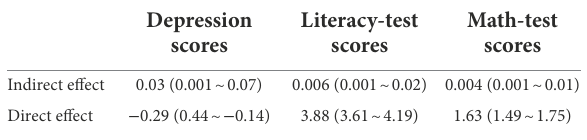
TABLE 7 Mediating effect of life satisfaction. TABLE 8 Mediating effect of life satisfaction.